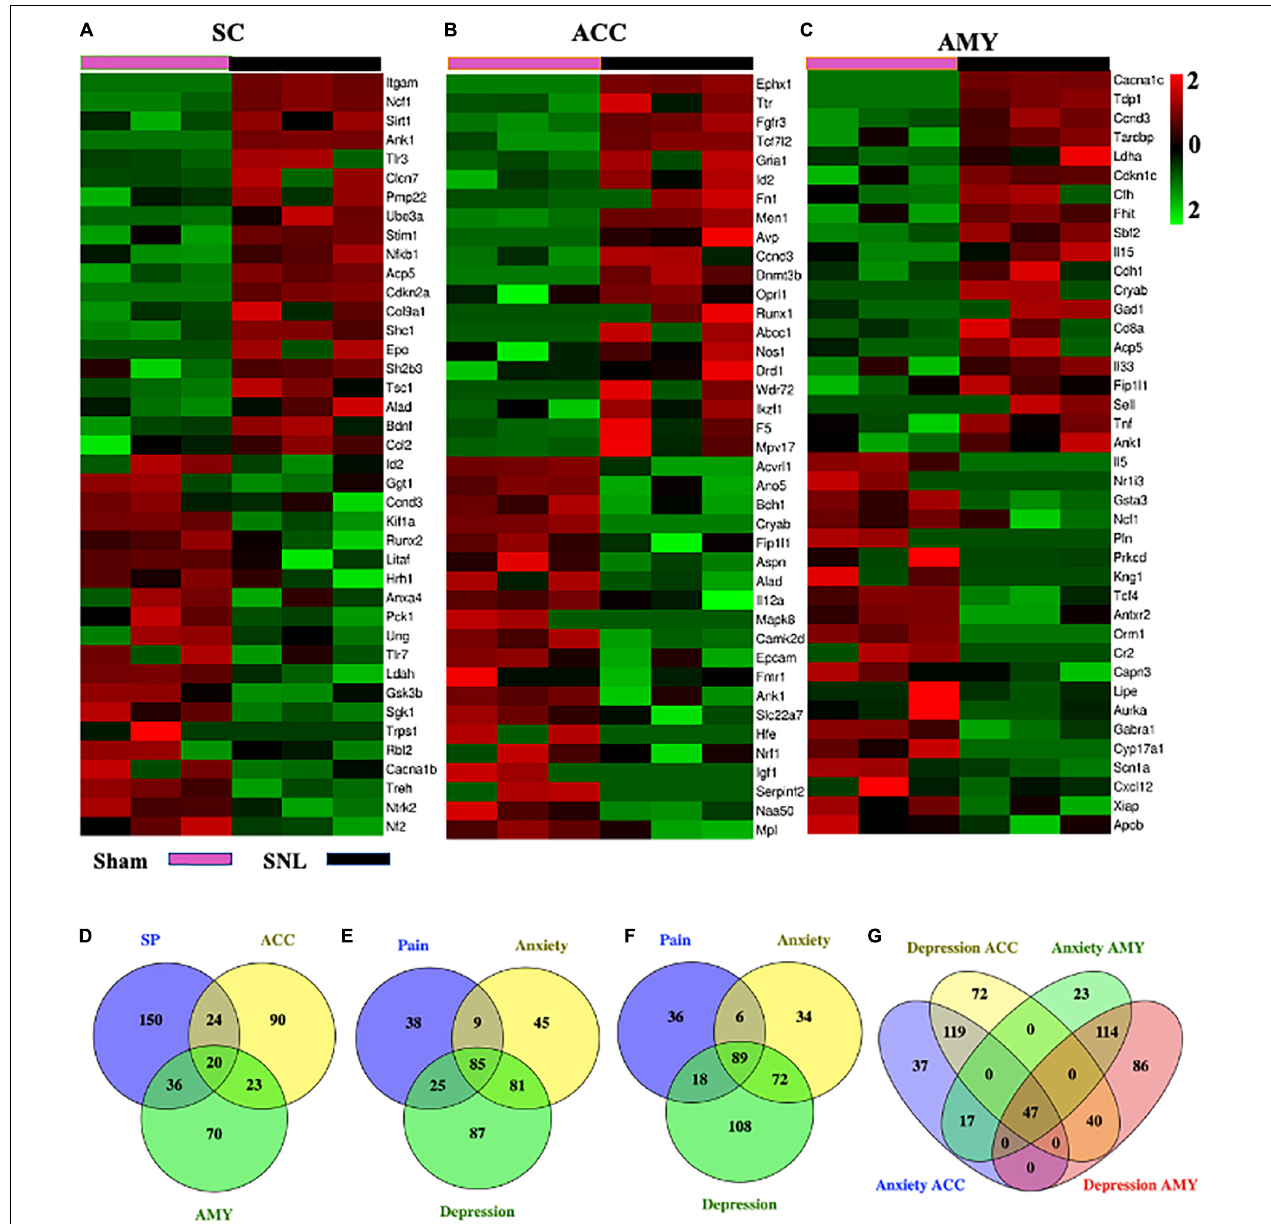
FIGURE 8 | Comparisons of pain-, anxiety-, and depression-related genes in the SC, ACC, and AMY. (A–C) Heatmaps of representative top 20 up- and downregulated pain-related DEGs in the SC (A) , ACC (B) , and AMY (C) on day 7 after SNL. (D) Venn diagram indicated the number of the overlapped pain-related genes among the SC, ACC, and AMY on day 7 after SNL. Detailed information was displayed in Supplementary Table 3 . (E–G) Venn diagrams indicated the number of overlapped pain-, anxiety-, and depression-related DEGs in the ACC and AMY (detailed information in Supplementary Table 4 ). Colors in the heatmaps indicate the Row Z-score among the different datasets. Up- and downregulated genes are colored in red and green,